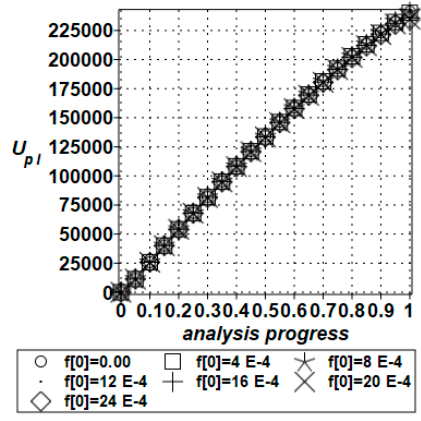
Figure 4. Plastic energy variations during deformation.